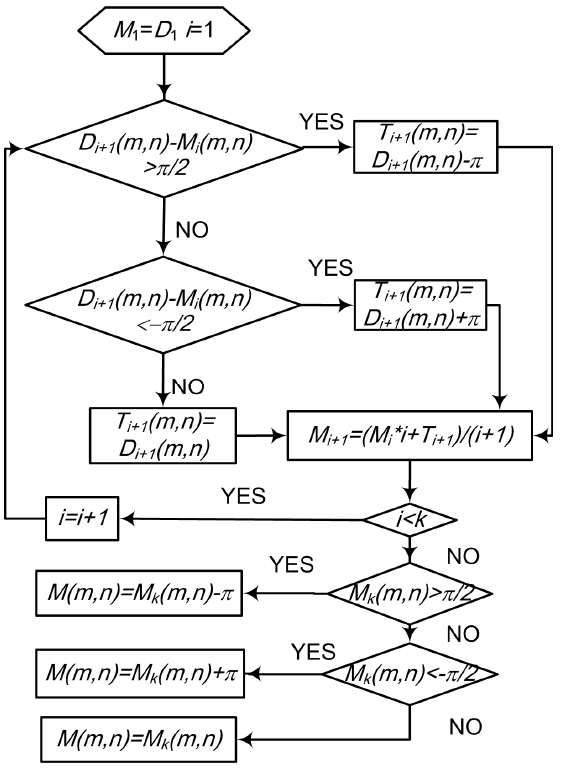
Figure 8. Flowchart for the average of the DF